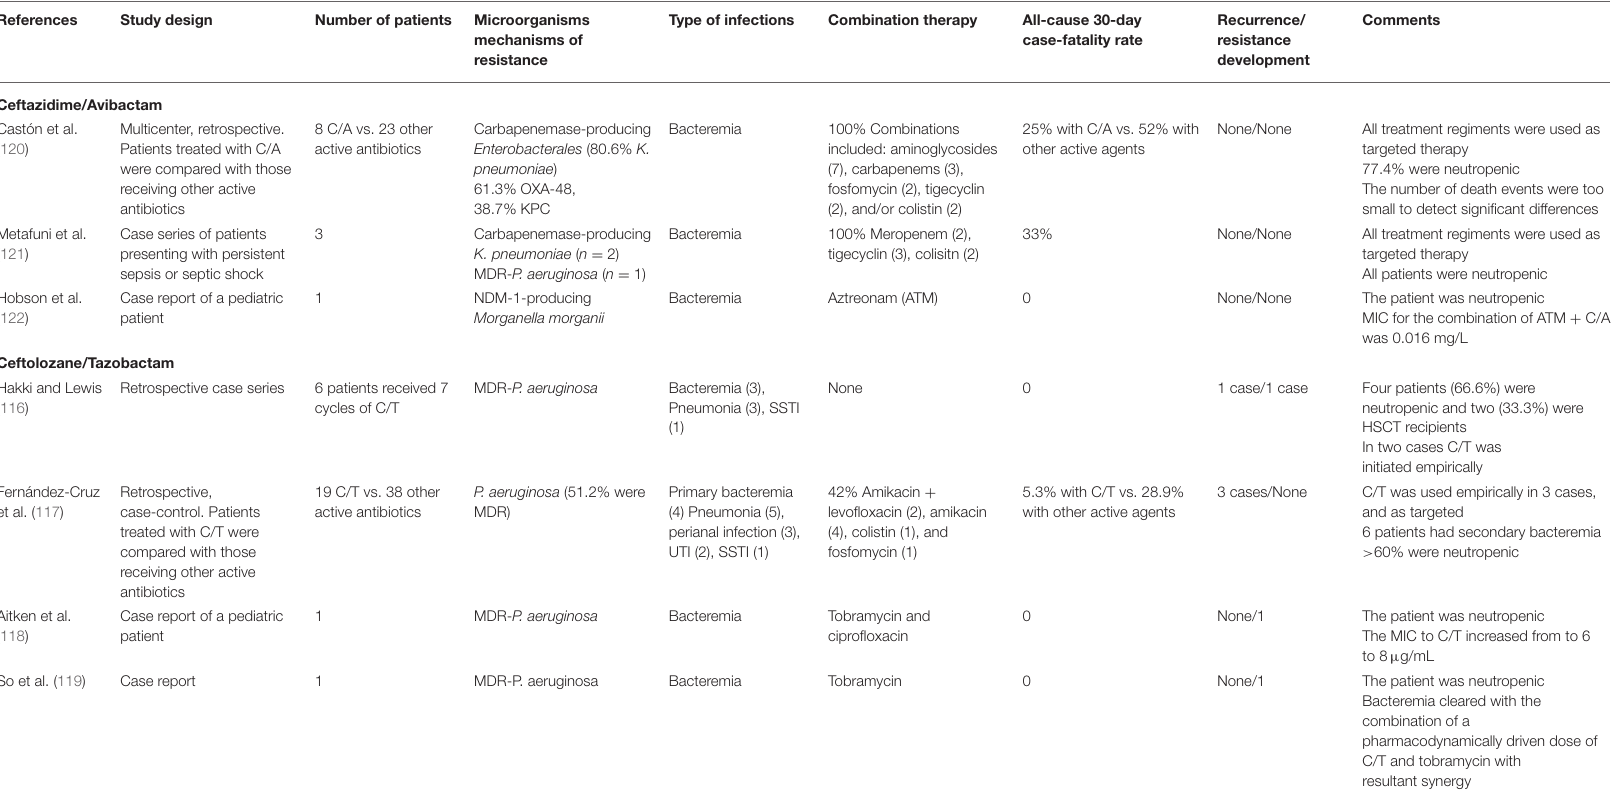
TABLE 3 | Summary of the main clinical and microbiological characteristics of the published case series and case reports on the use of ceftazidime/avibactam and ceftolozane/tazobactam in high-risk hematologic cancer